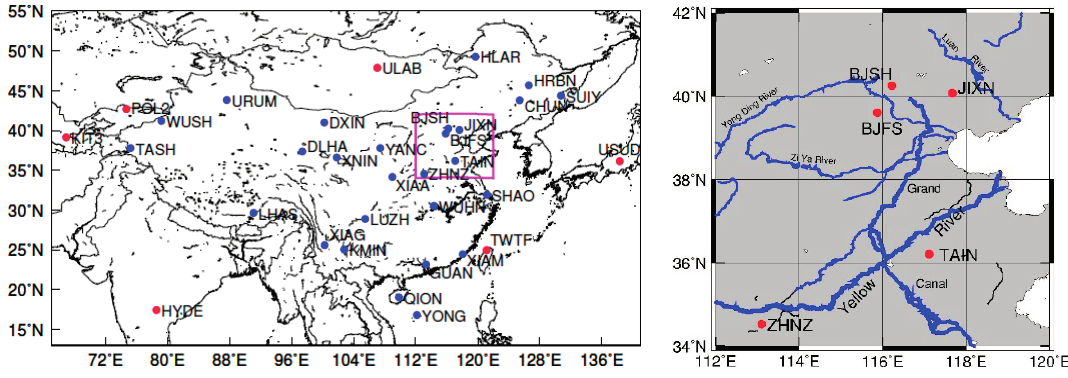
Figure 1. (Left) Distribution of continuous GPS stations (blue dots) and selected IGS stations (red dots) ( Right ); Enlarged view of the box area ( Left ) displayed with the Yellow River and its major tributaries in the study